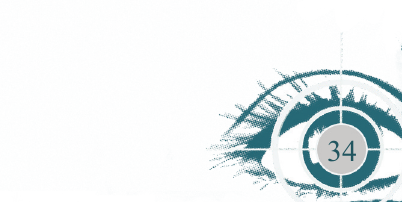
Figure 2 : Reported frequency of colour vision problem experi- ences and percentages of the respondents. A few welders (13%) reported having had this problem for longer than 12